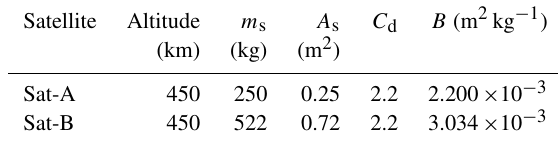
Table 1. Orbital and ballistic parameters used in this